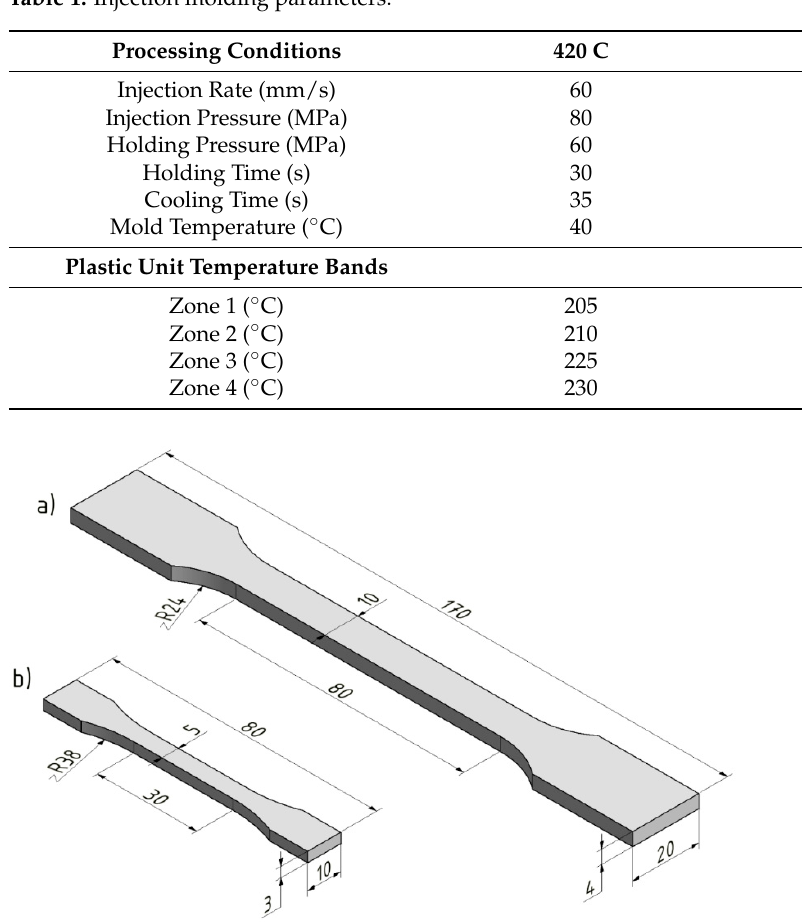
Figure 1. Shape and dimensions of tested specimens: ( a ) tensile test, ( b ) tensile impact test.